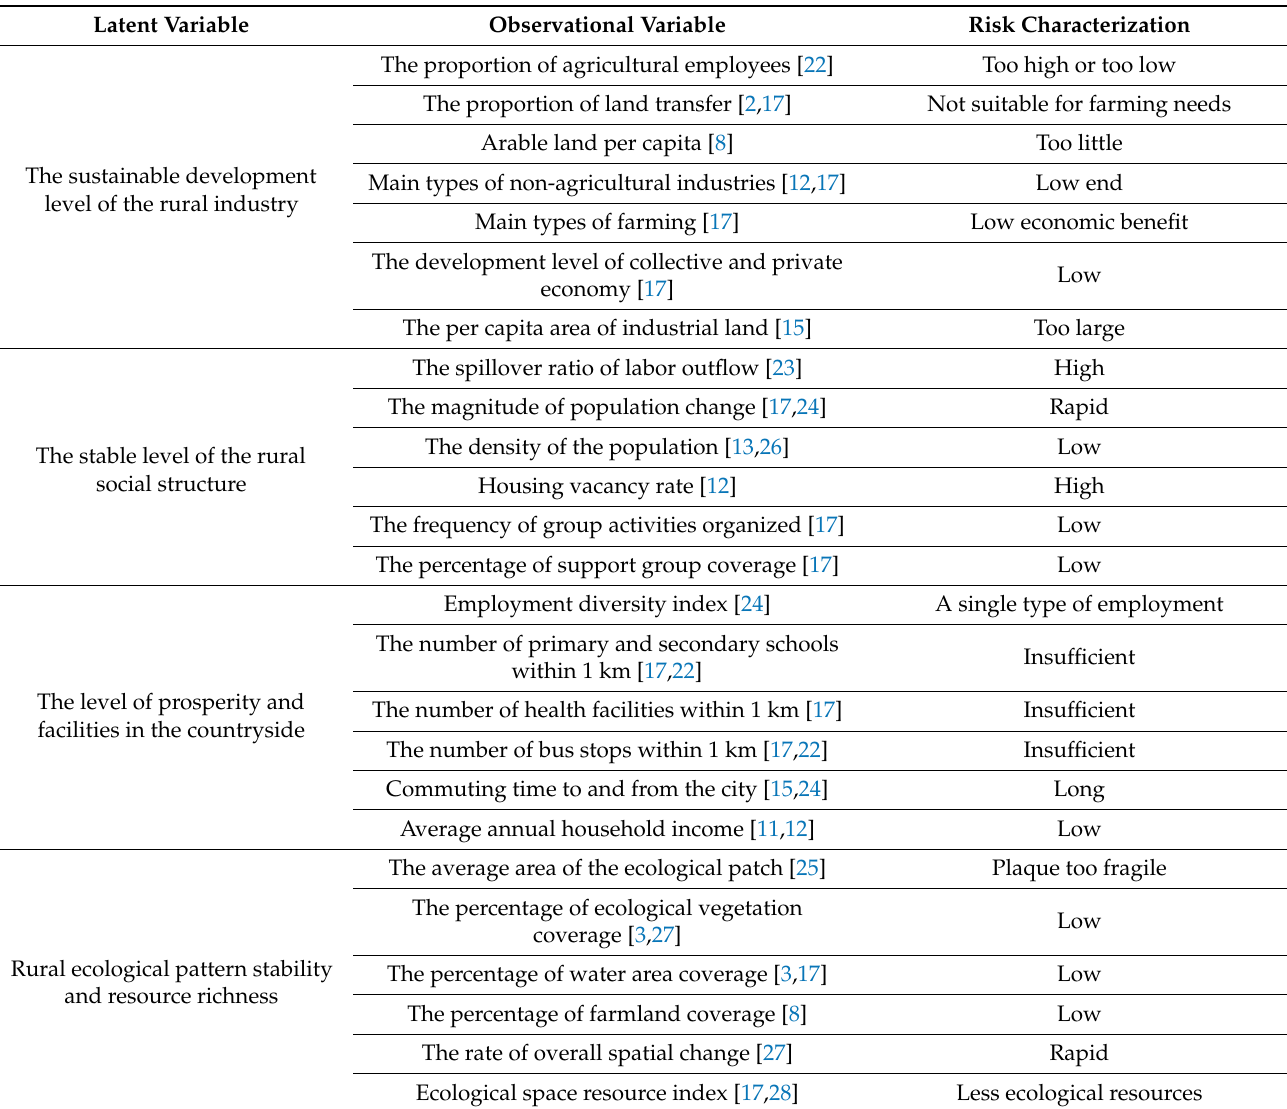
Table 2. Observational variables of systemic risk factors in suburban